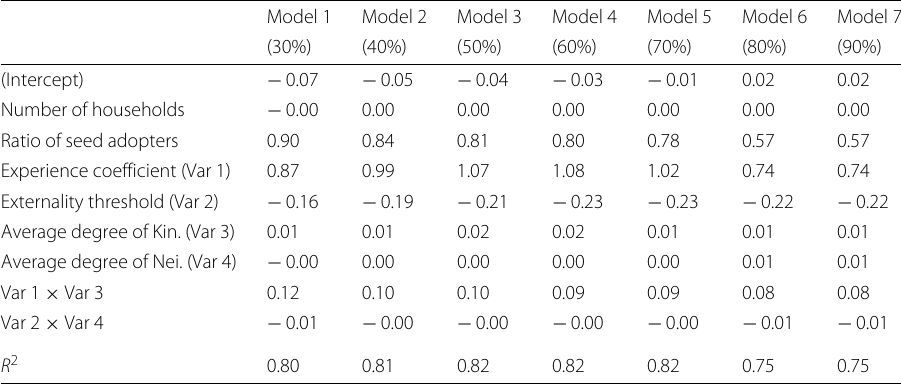
Table 4 Regressions of adoption speed on average degree (positive externality